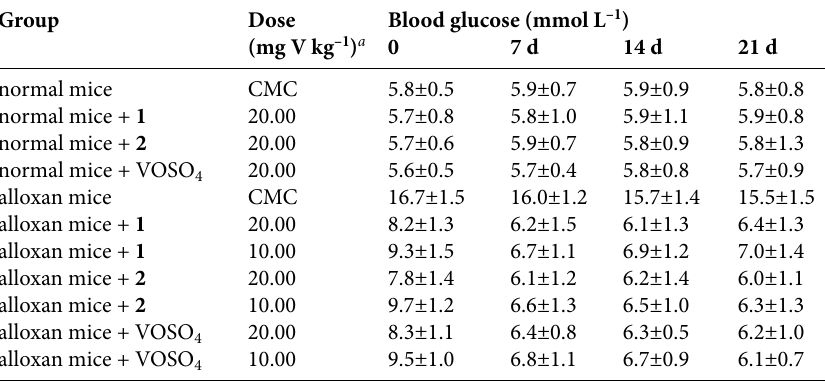
Table 4 Effects of the complexes on blood glucose levels of mice Group Dose Blood glucose (mmol L –1 )